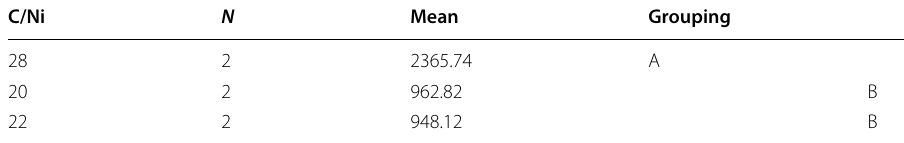
Table 8 Tukey’s test associated with C/Ni and TF effects on NO3 –